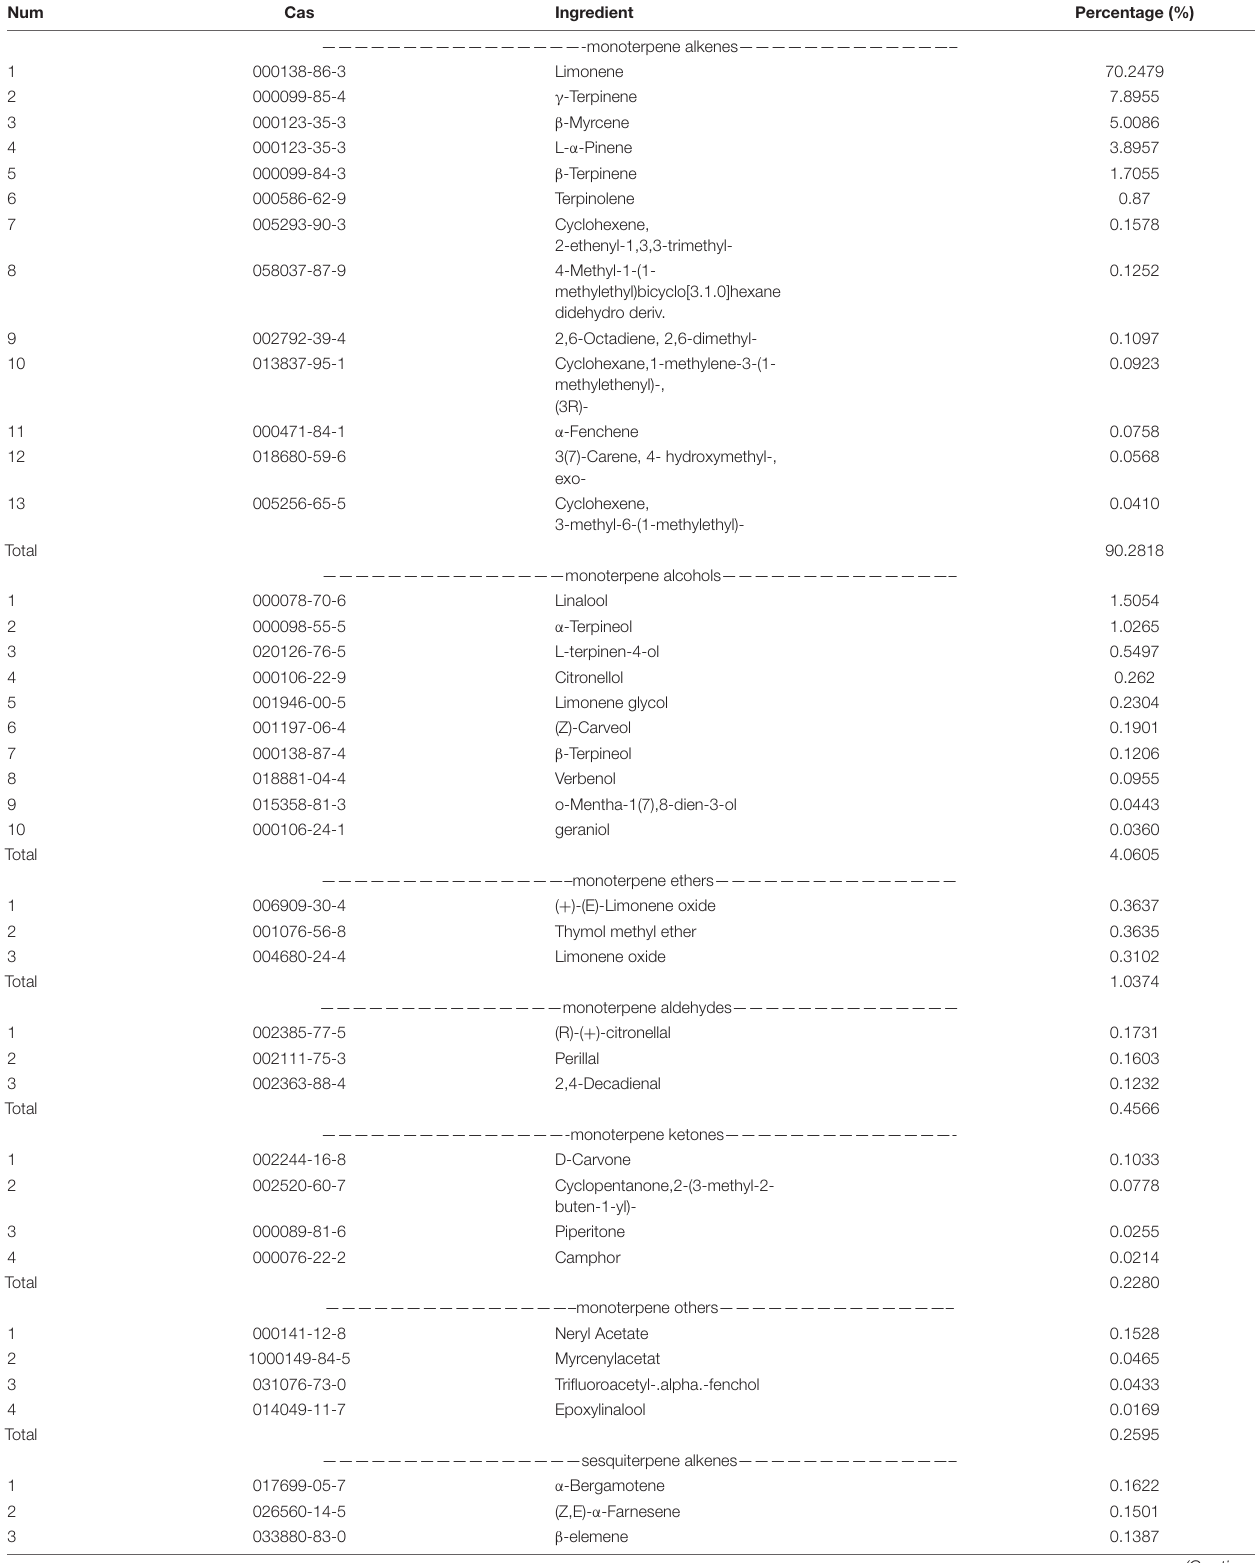
TABLE 1 | Chemical composition of